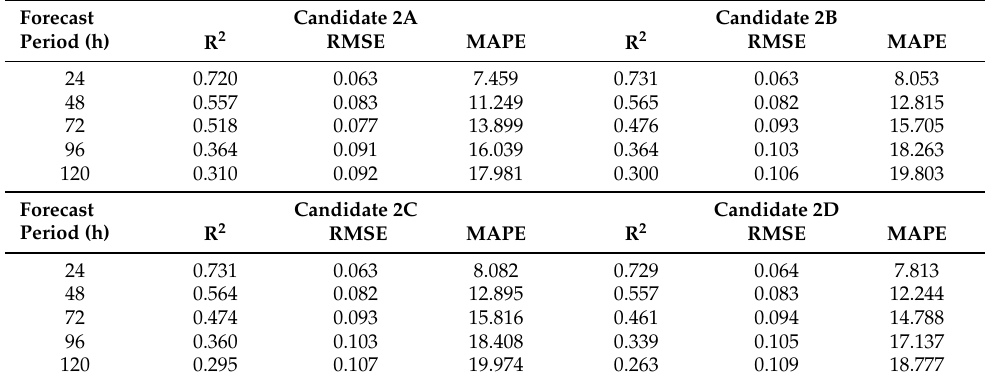
Table A3. The validation results of the combined model(LWL) fitted with MLR.